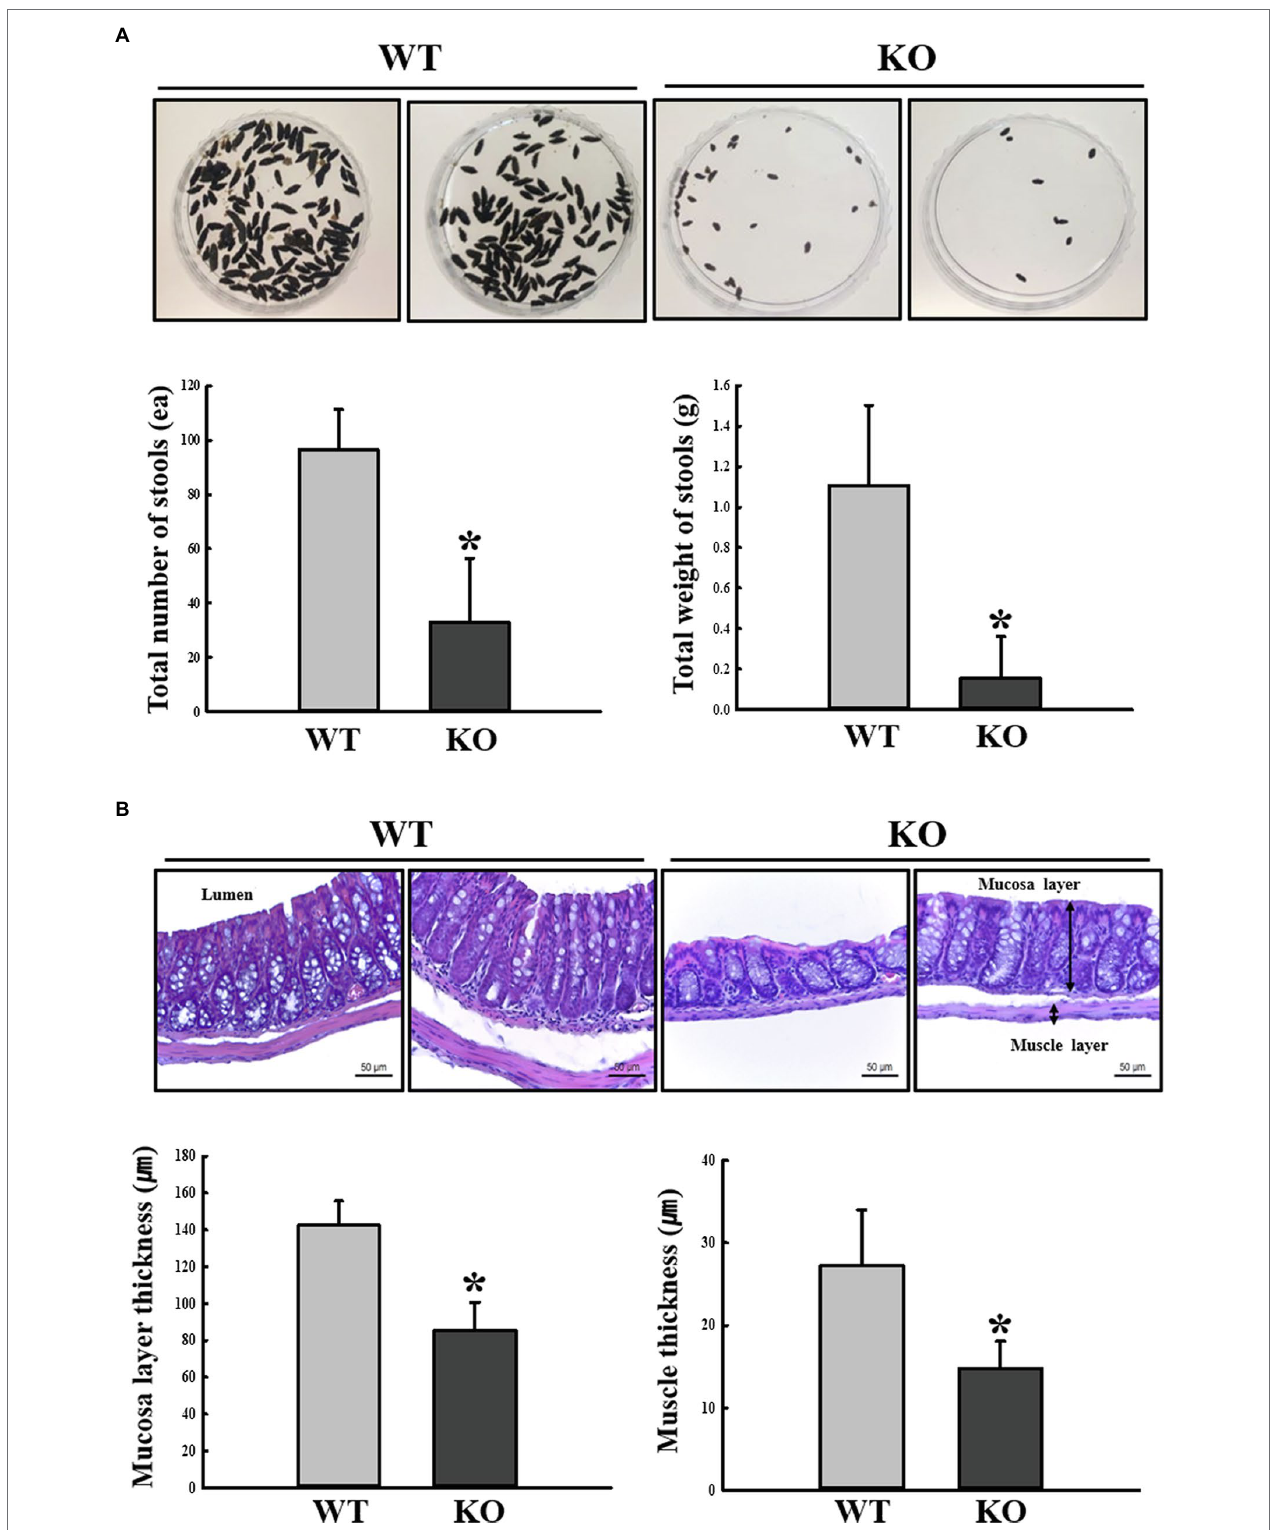
FIGURE 2 | Stool parameters and histopathological structures of mouse mid-colon. (A) Digital camera images of stools were taken immediately after collection from a metabolic cage. Total number and weight of stools were measured as described in Materials and Methods. Three to five mice per